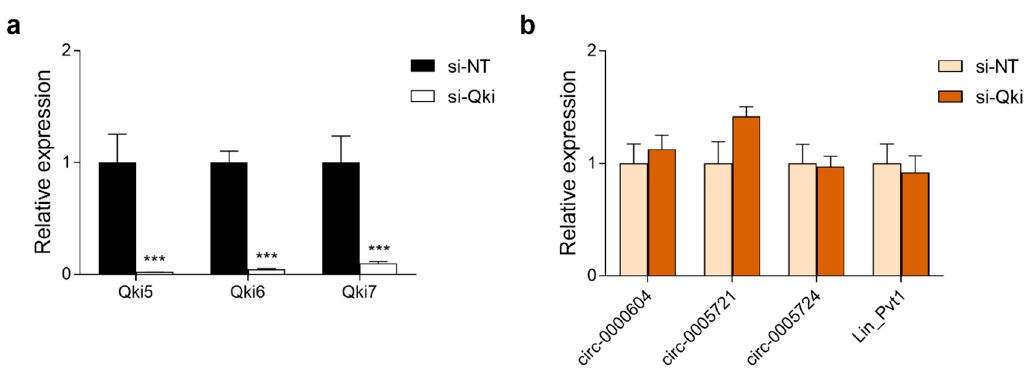
Figure 10. Silencing of the circRNA biogenesis regulator Quaking does not affect expression of Pvt1 circRNAs in Neuro2a cells. ( a ) Qki isoforms were effectively silenced by Qki siRNA (si-Qki) in comparison to non-targeting siRNA (si-NT). ( b ) No effect of Qki silencing on expression of Pvt1 transcripts. Data are means + s.e.m. of 4 biological replicates ( n = 4). Statistics were performed using Student’s t -test; *** p < 0.001.